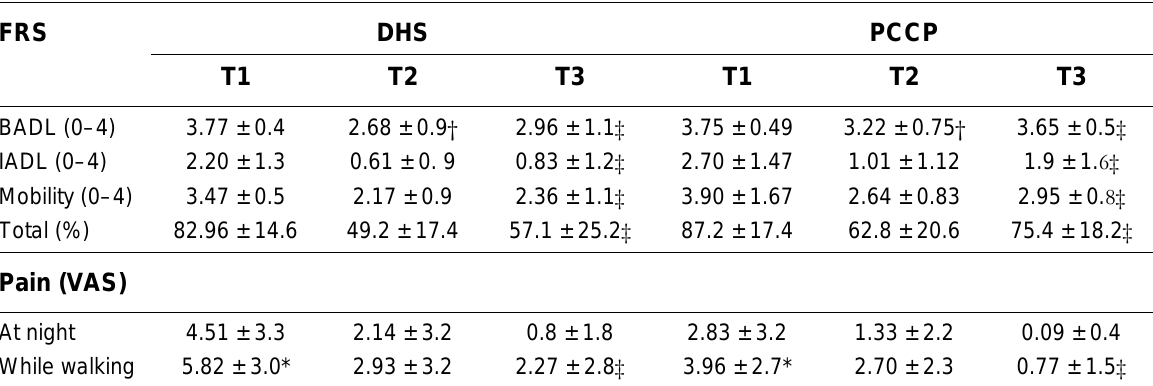
Mean ± SD FRS, Pain Level, and Walking Speed of Subjects at the First (T1), Second (T2),